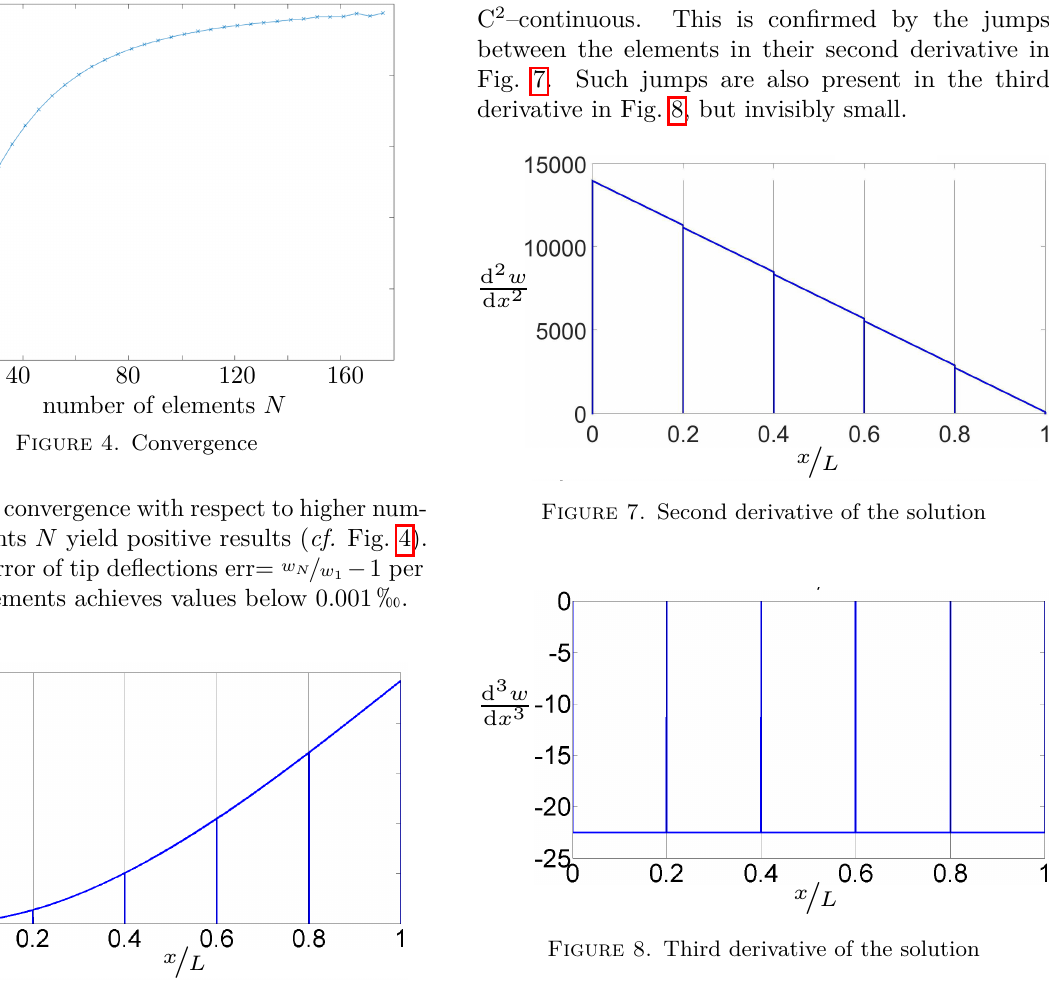
Figure 5. Deflection line